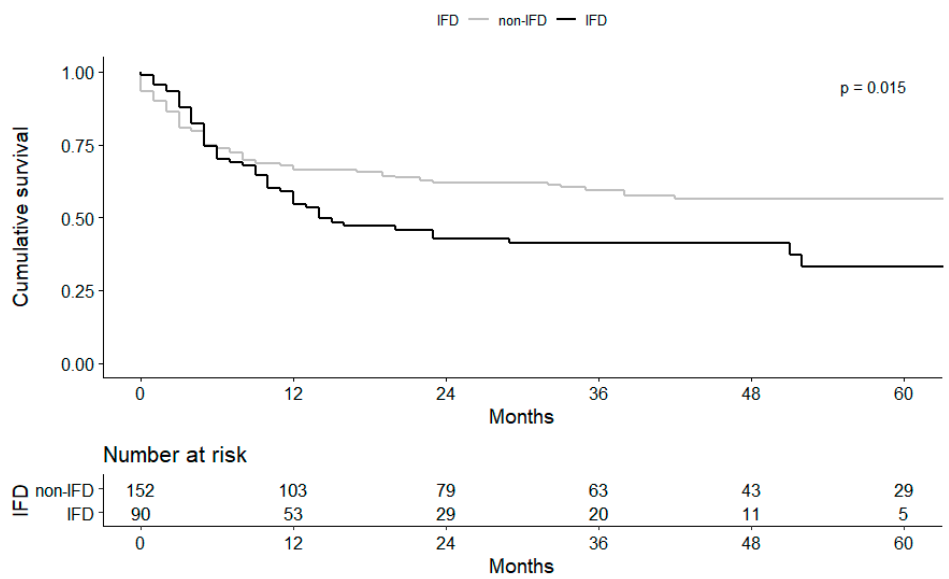
Figure 3. Classification of invasive fungal diseases. DS, disseminated fungal infection; TB, tracheo- bronchitis.